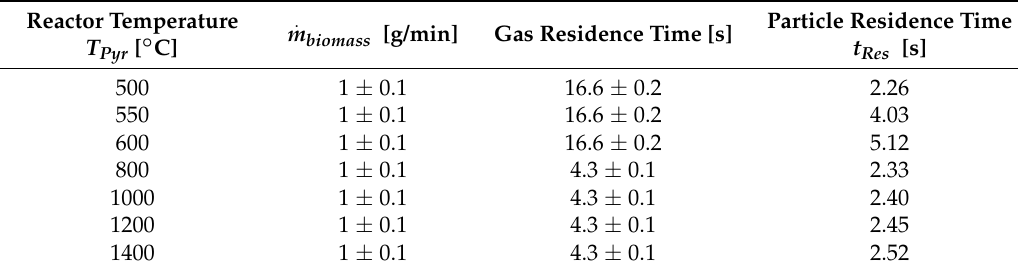
Table 2. Pyrolysis experimental conditions in the